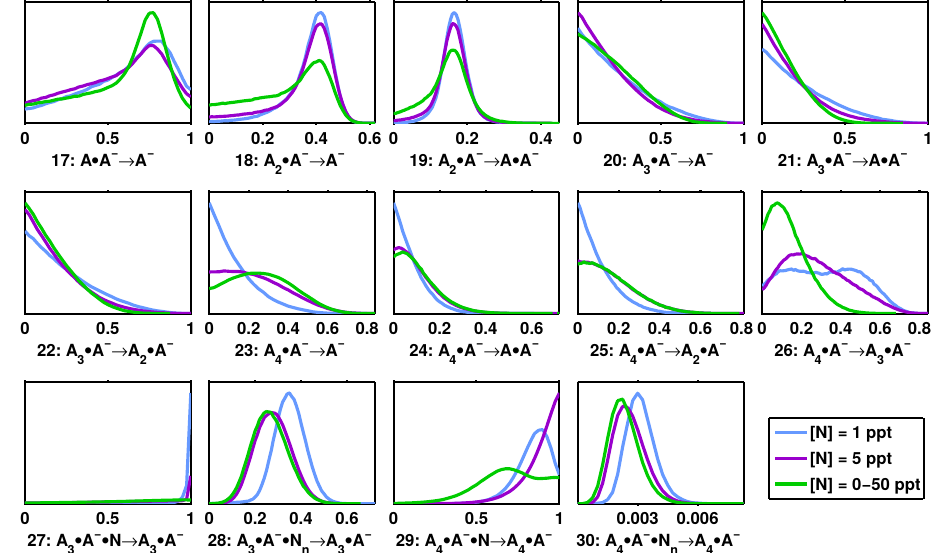
Figure 5. Posterior distributions of the fragmentation probabilities in the mass spectrometer inlet corresponding to the experimental cluster distributions and different options for treating the background ammonia concentration in the experiments where it was below the detection limit and therefore unknown. “A” stands for H 2 SO 4 , “A − ” for HSO − and “N” for NH 3 . 4